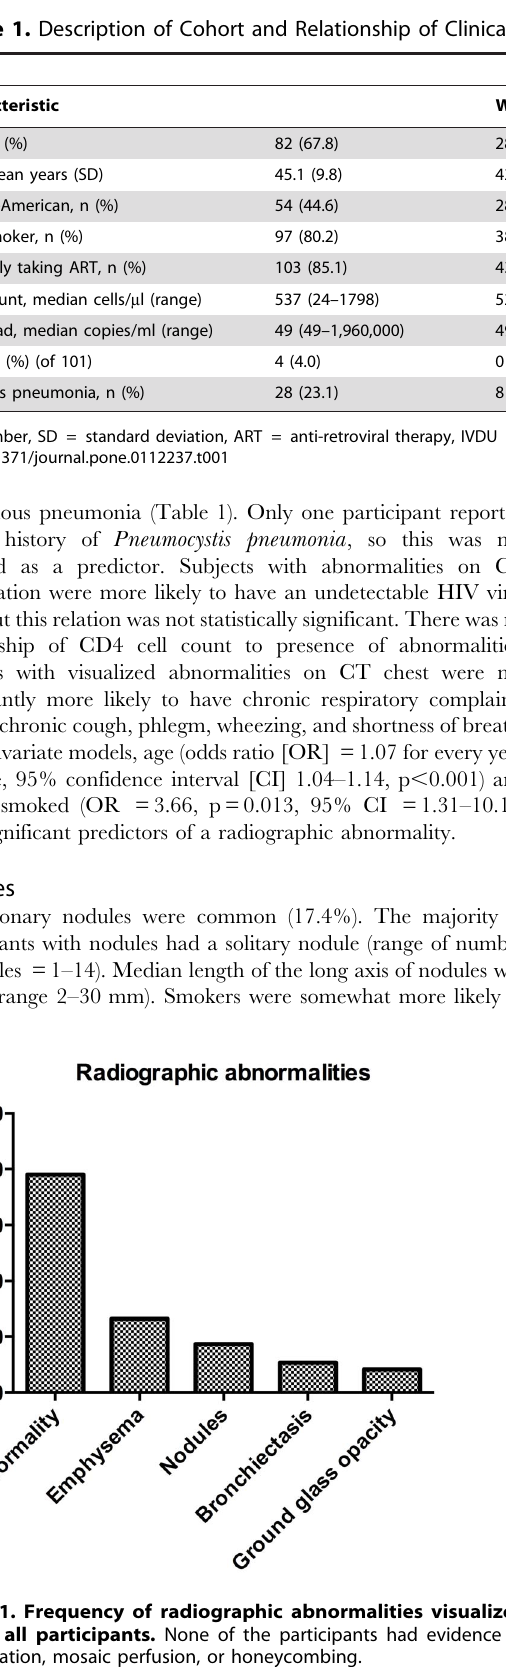
Table 1. Description of Cohort and Relationship of Clinical Variables to Radiographic Abnormalities, n =121.